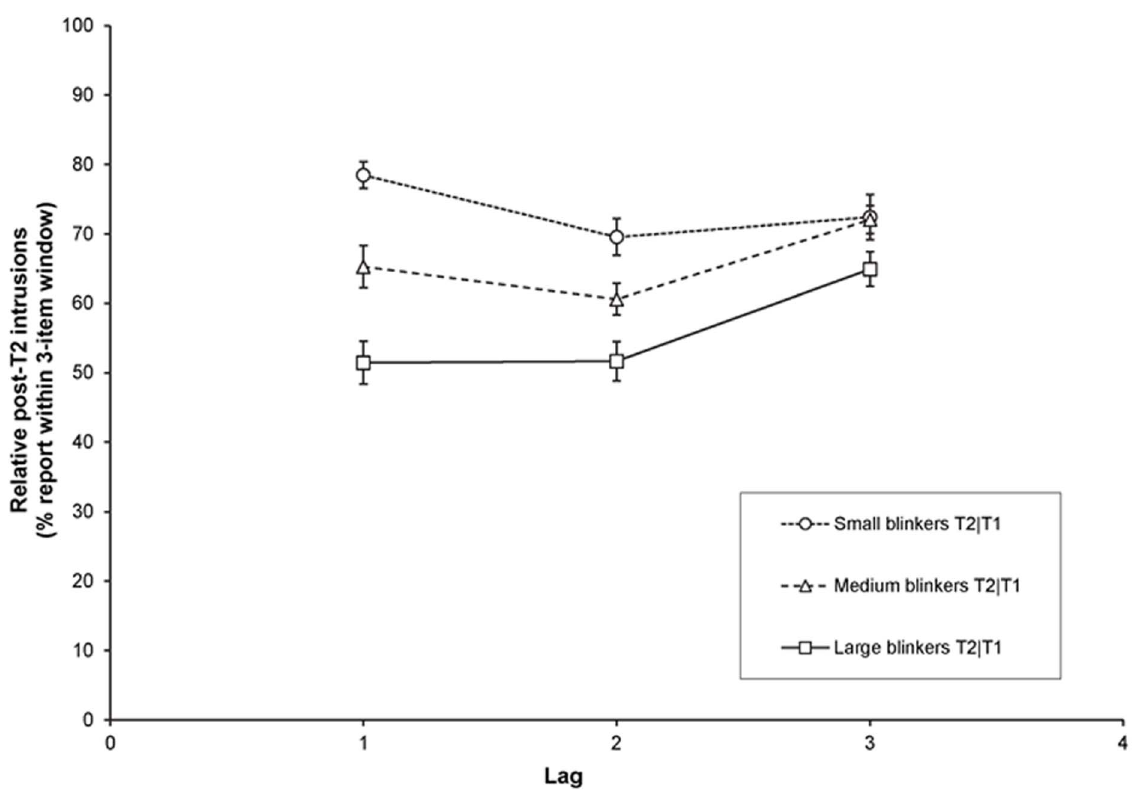
Figure 13. Intrusion errors in Experiment 2. Percentage of erroneously selected letters (relative to all trials with an incorrect T2 response) presented 1–3 serial positions following T2 as a function of lag, for small, medium, and large